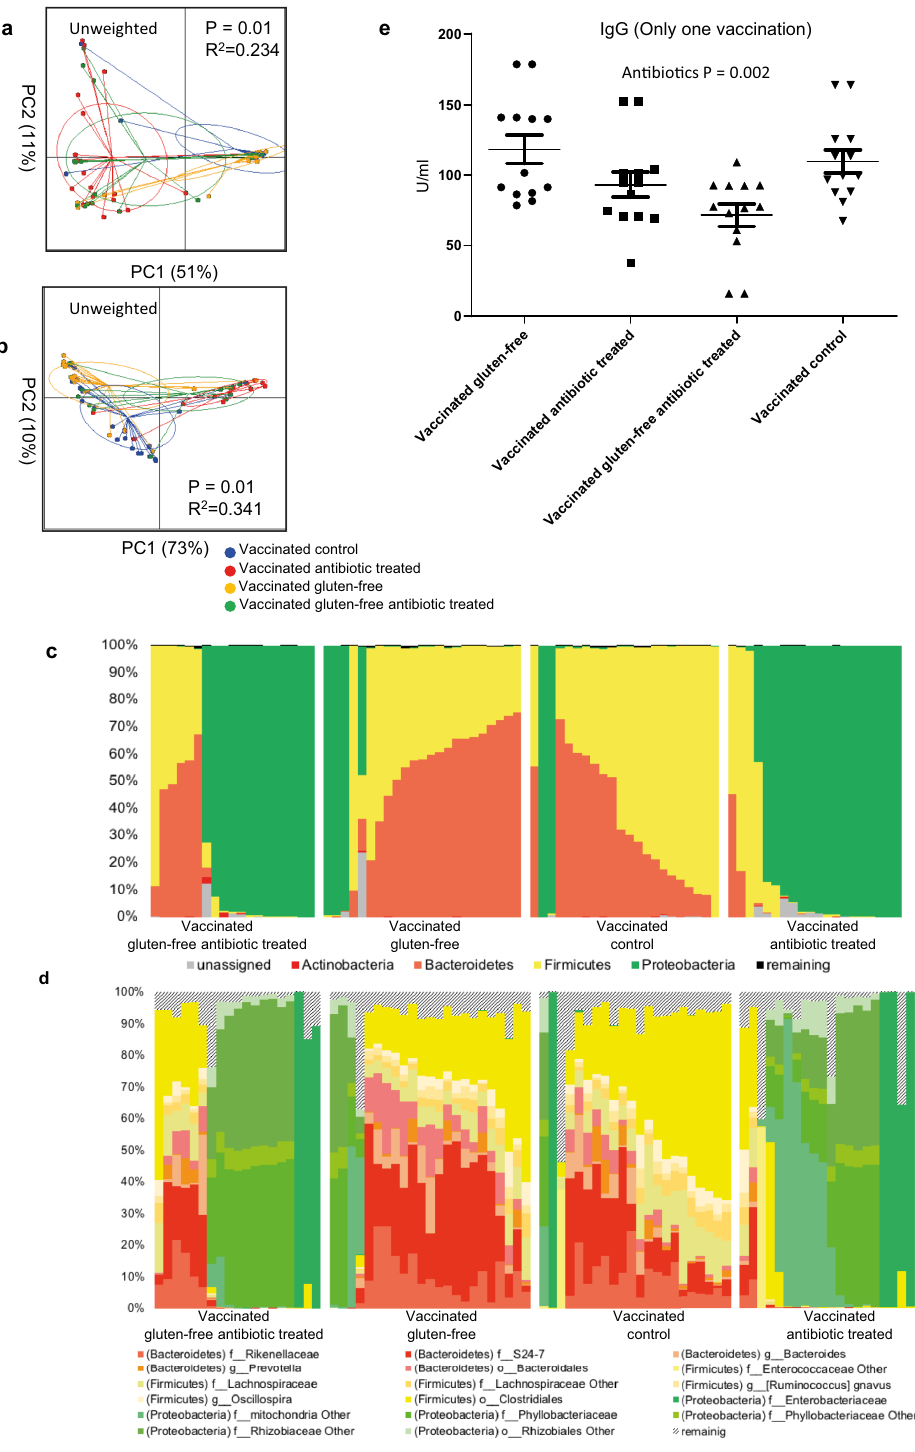
Fig 4. The impact of a gluten-free diet and antibiotics on gut microbiota and IgG response to tetanus vaccination. BALB/cBomTac mice were either fed a standard Altromin wheat based diet (‘gluten’), or they were fed a modified Altromin diet, in which wheat protein was replaced with casein (‘gluten-free’). Mice on both diets were either given ampicillin in the drinking water (Antibiotics; gluten-free + antibiotics) or given pure drinking water (Gluten-free; vaccinated control). All mice were vaccinated with a tetanus vaccine and one week later blood was sampled.